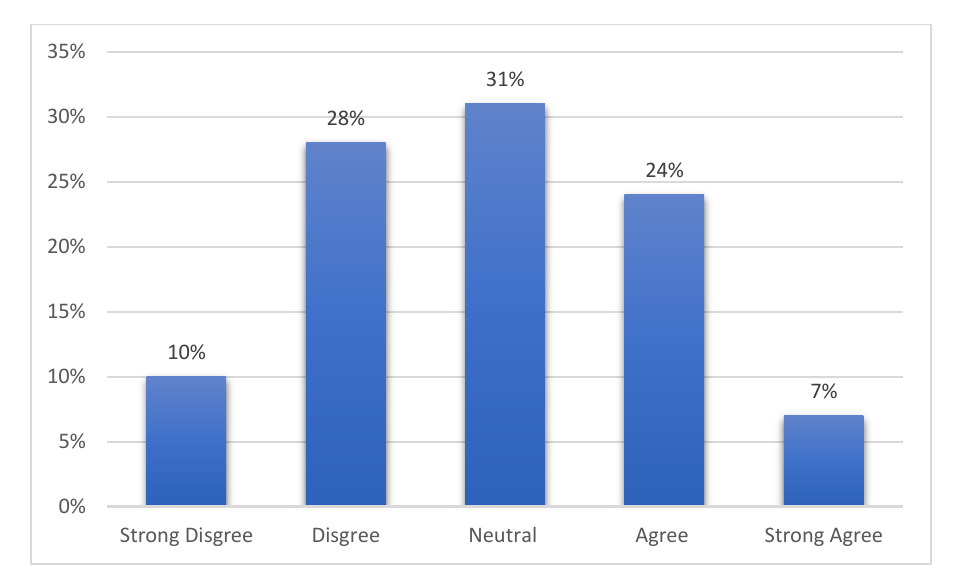
Figure 1: Emergency